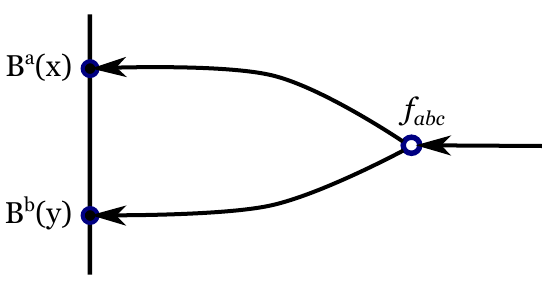
Figure 2 . The boundary algebra is determined by this diagram. The two boundary insertions, B a ( x ) and B b ( y ) , are connected to the bulk vertex f abc B a A b ∧ A c . A line with an arrow denotes the h BA i propagator, with the arrow pointing at B . Similar Feynman rules were used in [21]. free where x , x are positions of some insertions. In the x 1 2 i.e. e and m independent, terms can